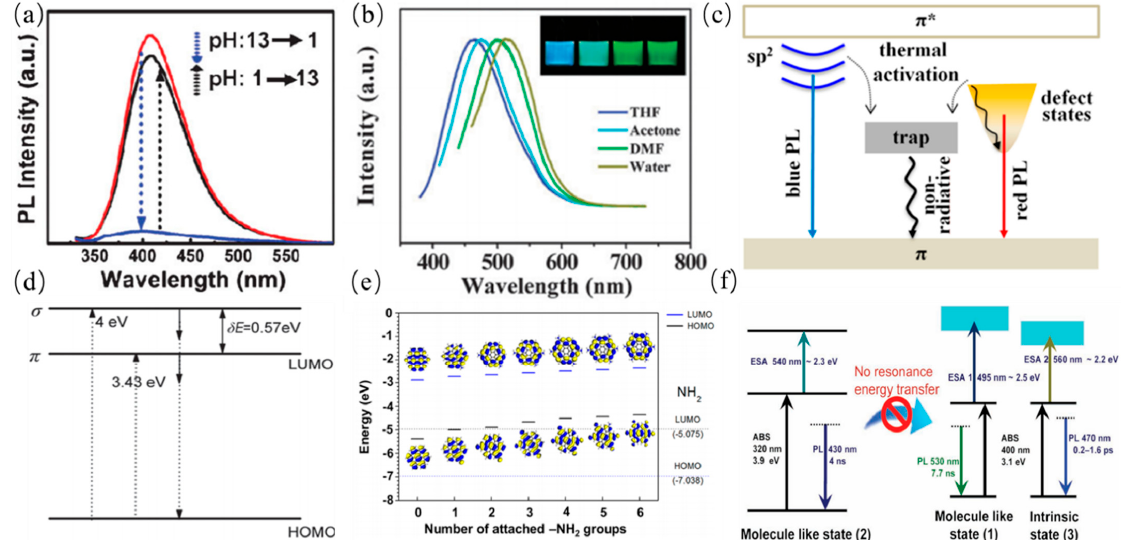
Figure 12. ( a ) The pH-dependent behavior of GQDs [74]. Copyright 2010, John Wiley and Sons. ( b ) The solvent-dependent PL emission behavior of GQDs [96]. Copyright 2011, Royal Society of Chemistry. ( c ) Surface/edge states emission mechanism of the GQDs [127]. Copyright 2013, American Chemical Society. ( d ) HOMO and LUMO energy levels of carbon core functionalized by the different numbers of -NH 2 moieties [121]. Copyright 2012, Royal Society of Chemistry. ( e ) The two independent molecule-like states and a dark state existed in GQDs [128]. Copyright 2013, American Chemical Society. ( f ) the band gap of GQDs with number of attached-NH 2 groups [129]. Copyright 2013, John Wiley and